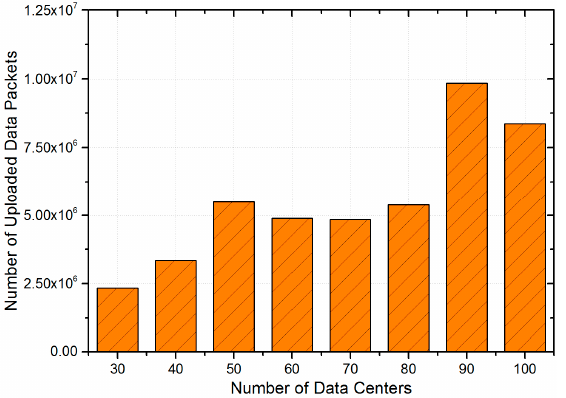
Figure 13. Total number of uploaded data packets with different number of data centers.